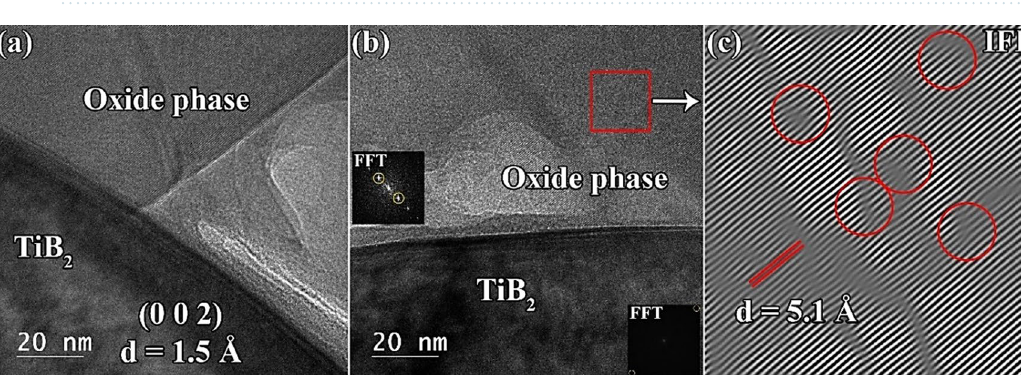
Figure 8. TEM images of the C f -incorporated TiB 2 –SiC composite showing ( a ) TiB 2 and SiC phases, ( b ) an intergranular TiB